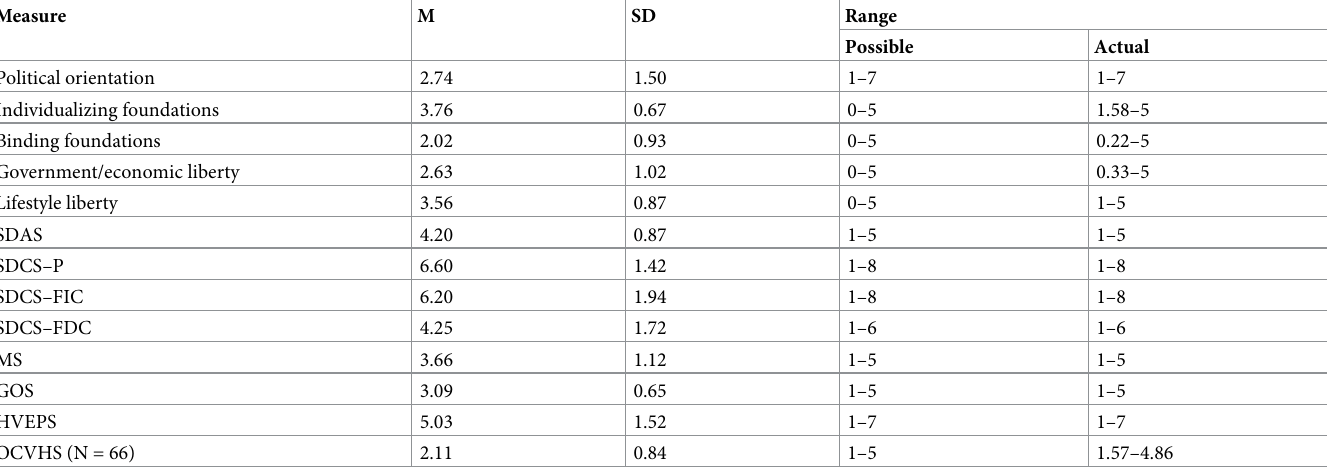
Table 2. Descriptive statistics for key predictor and outcome measures (N =